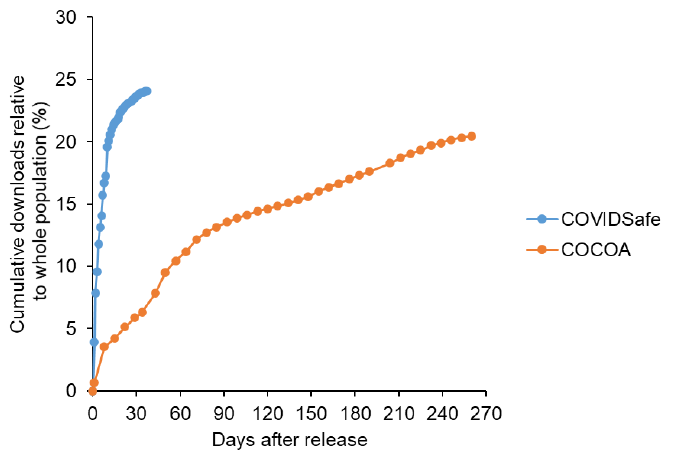
Figure 3. Growth curve of downloads based on Bass’s new product growth model with varying imitation factor ( left panel) and varying innovation factor ( right panel).